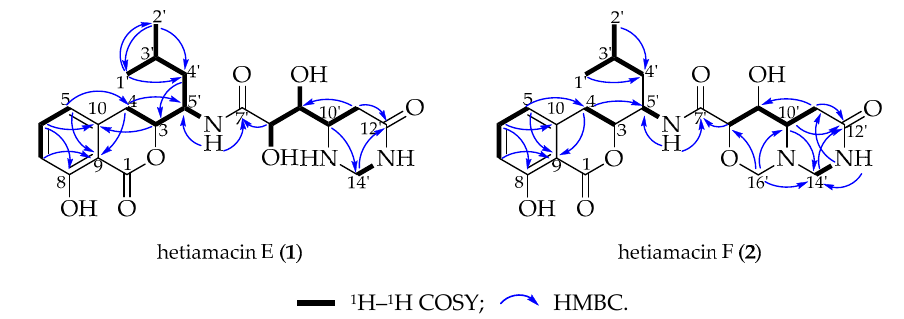
Figure 4. Major 2D NMR correlations of hetiamacin E ( 1 ) and hetiamacin F ( 2 ).